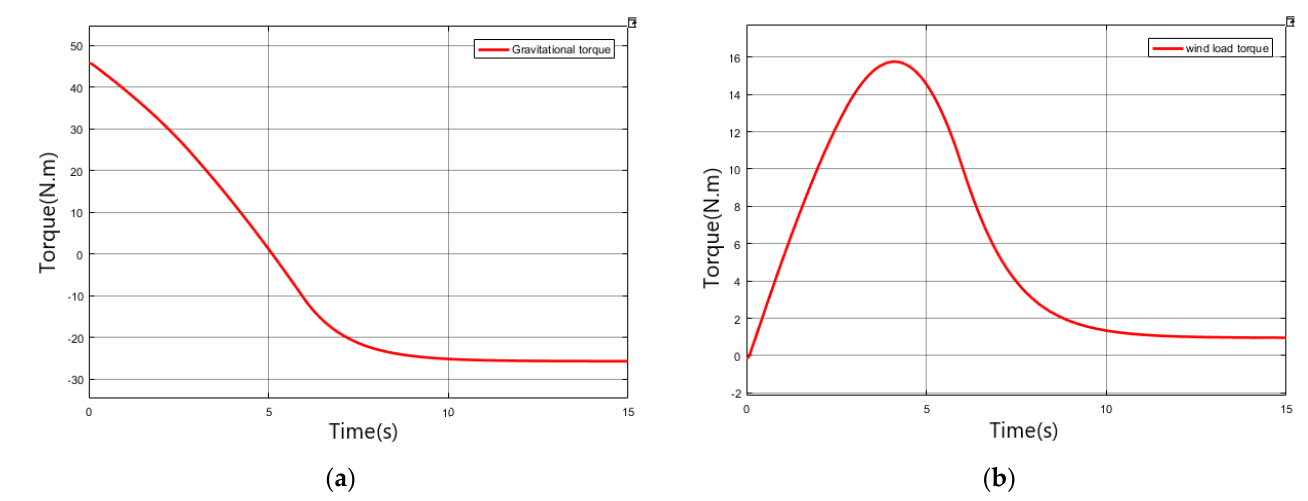
Figure 4. Variation of the load torque and wind load torque during the erection process relative to point O 2 . ( a ) Gravitational torque; ( b ) wind load torque.